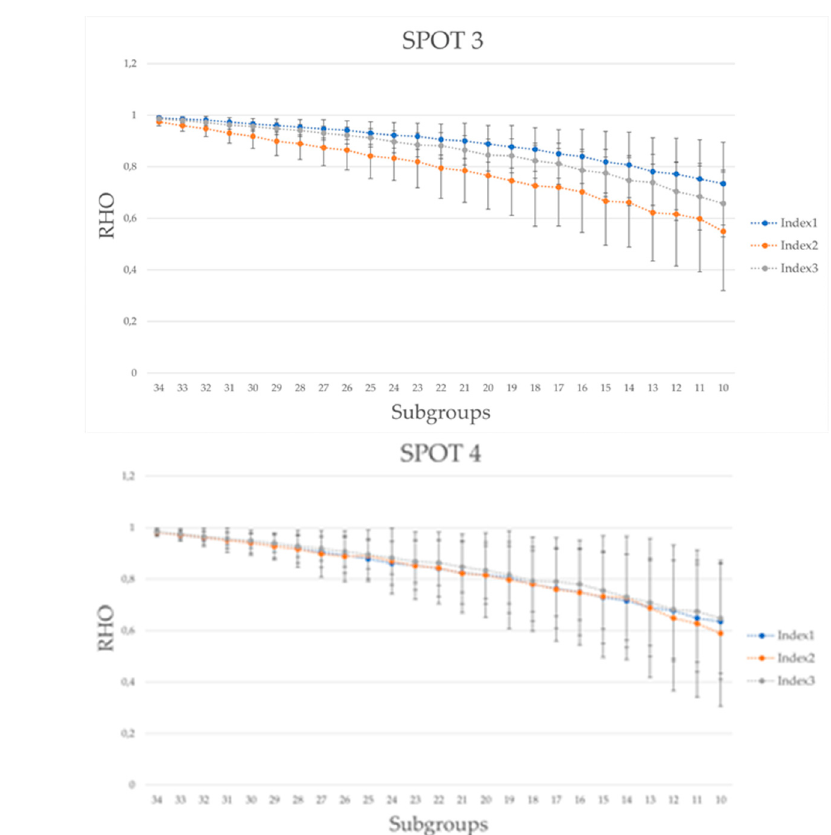
Figure 3. Graphical representation of the trend of rho correlation coefficient at reducing the sample size (subgroups) with respect to the ‘full population index’ (36 participants). Tasks ( a ) and ( b ) were 30 s long, Task ( c ) 20 s, and Task ( d ) 15 s long.